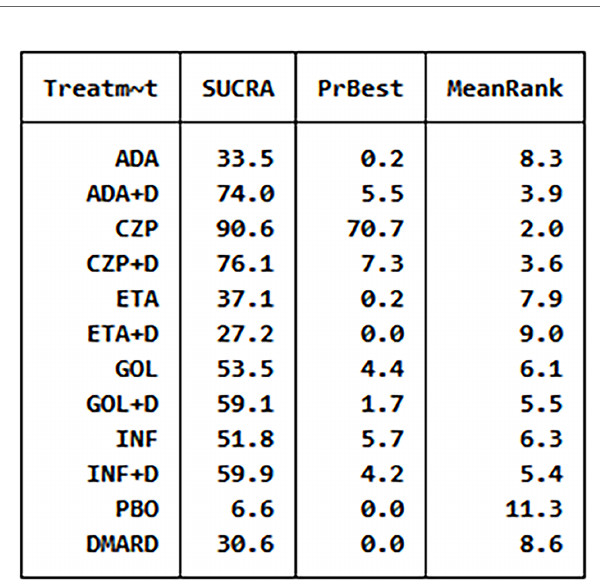
FIGURE 2 | Network of treatment comparisons for adverse events. The size of the circles corresponds to the total number of people. Direct comparable treatments are connected with a line. ADA, adalimumab; + D, plus DMARD; CZP, certolizumab; ETA, etanercept; GOL, golimumab; INF, in fl iximab; PBO, placebo; DMARD, disease-modifying anti-rheumatic drugs.